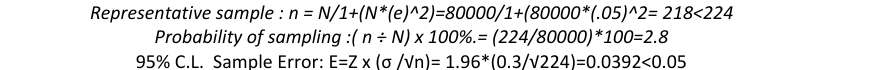
Table 1: Sample demographics (N =224) Representative sample : n = N/1+(N*(e)^2)=80000/1+(80000*(.05)^2= 218<224 Probability of sampling :( n ÷ N) x 100%.= (224/80000)*100=2.8